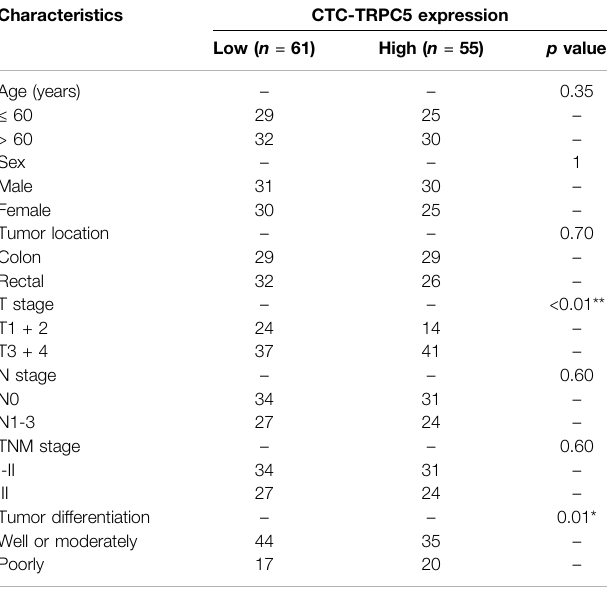
TABLE 3 | Characteristics of CRC patients according to IHC-TRPC5 level.